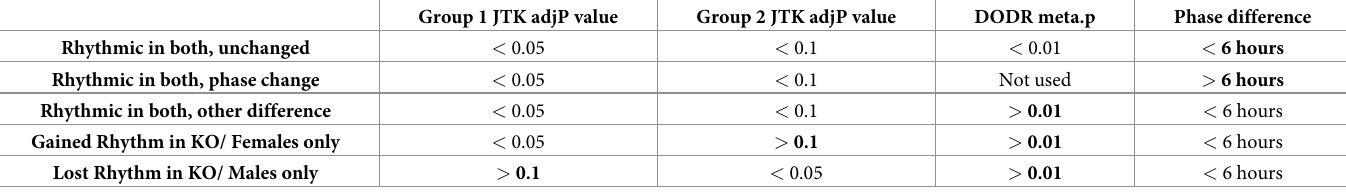
Table 1. Statistical criteria used to filter genes into the categories listed in the left column. Bold are the key factor(s) for each